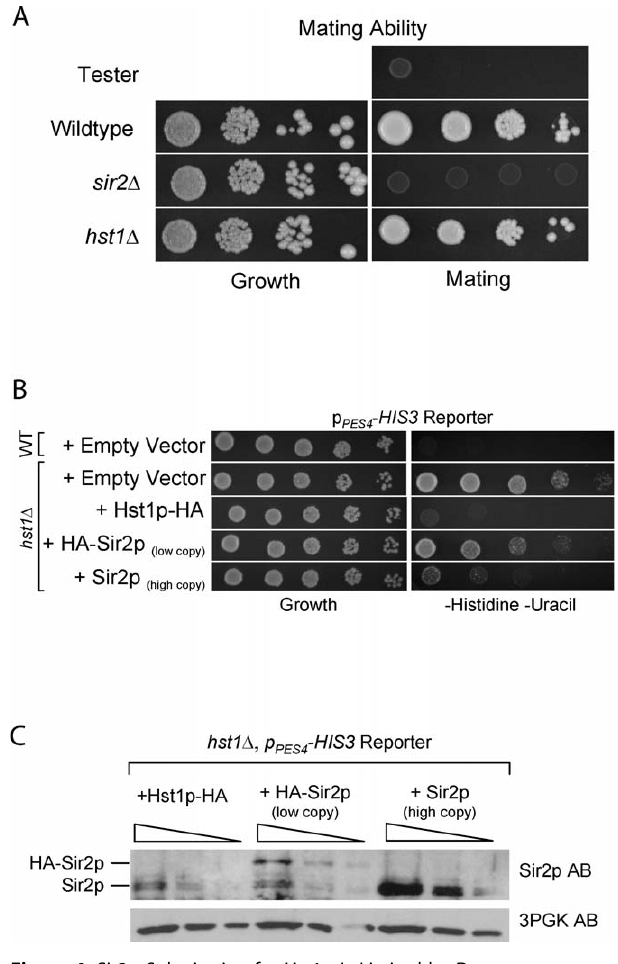
Figure 4. Sir2p Substitution for Hst1p Is Limited by Dosage (A) Mating ability was assayed using 10-fold serial dilutions of wild-type (W3031-a), sir2 D (LRY1079), and hst1 D (LRY198) strains mated against a MAT a tester strain (LRY1022). Prototrophic diploids were selected on minimal plates. A 10-fold dilution series of the tester strain was plated on minimal plates as a negative control. (B) The p PES4 -HIS3 reporter was used to assay Sum1p-mediated repression . Wild-type yeast (LRY1593) were transformed with an empty vector (pRS416), and hst1 D yeast (LRY1545) were transformed with an empty vector (pRS416), HST1-HA (pLR30), HA-SIR2 (pRO298 [low copy]), or SIR2 (pLP317 [high copy]). A five-fold dilution series of each strain was plated on rich medium and medium lacking histidine and uracil (to maintain plasmids) and photographed after 3 d growth at 30 8 C. (C) Immunoblot analysis showing relative amounts of Sir2p protein in the strains described in part B. Endogenous Sir2p (lower band) is present in all strains. The HA-Sir2p is slightly shifted because of the epitope tag. As a loading control, 3-phosphoglycerate kinase was